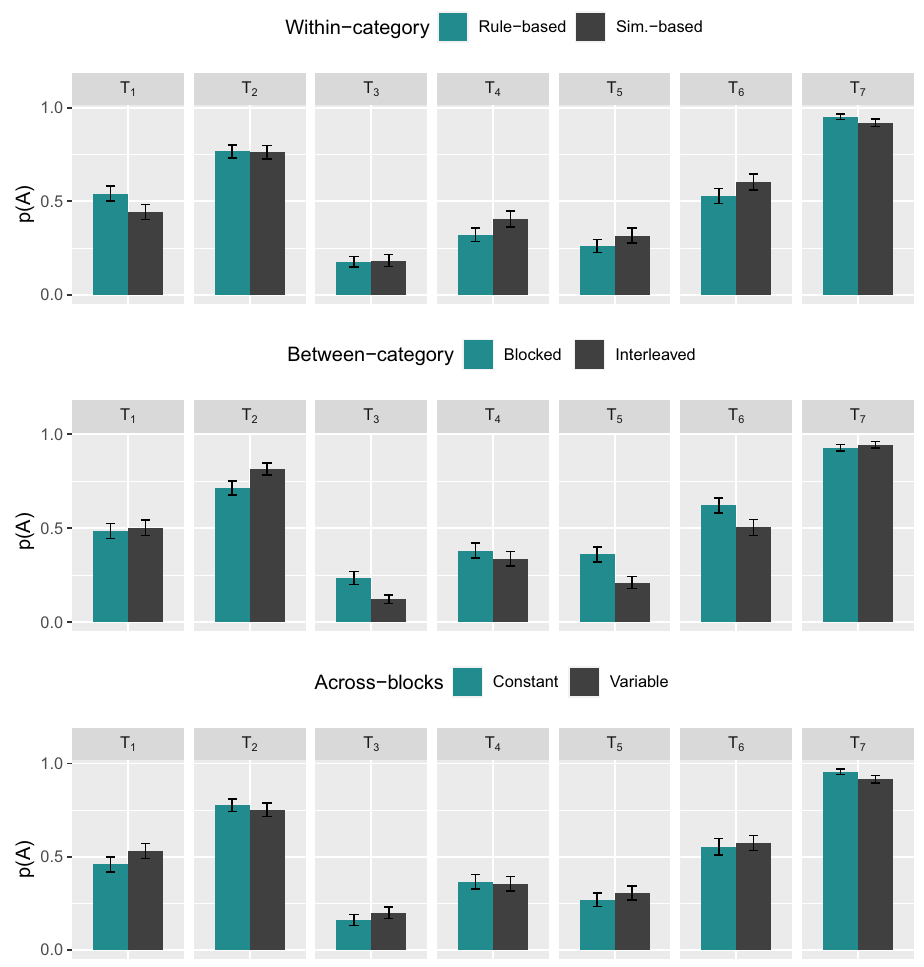
Figure 7. Average classification of the transfer items ( T 1 , T 2 , T 3 , T 4 , T 5 , T 6 , T 7 ) during the transfer phase (amounting to five blocks) as a function of types of order (taken separately). Quantity p ( A ) is the observed proportion that each of the stimuli labeled under the abscissa was classified into category A during the transfer phase. Quantity p ( A ) was first computed for each participants before being averaged across participants. Average classification of the nine learning items is not included. Error bars show ± 1 SE .